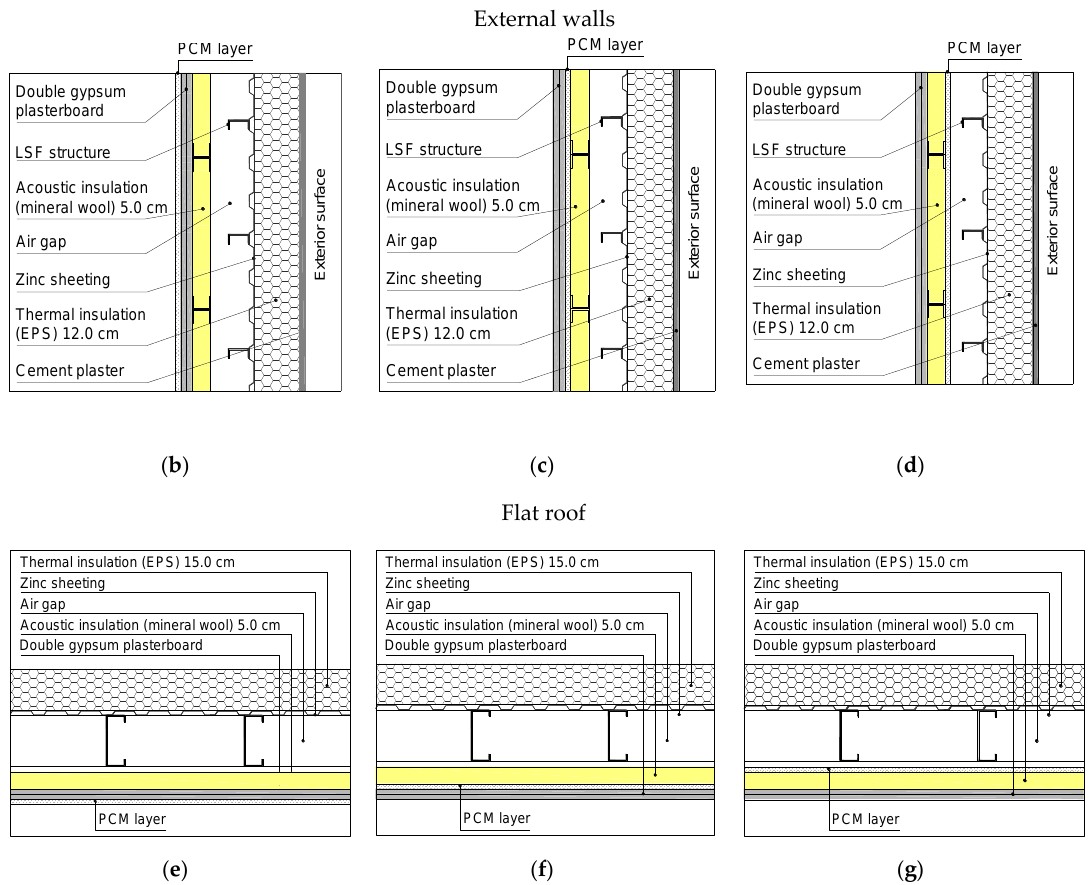
Figure 7. Constructive solutions details including PCM and positioning into the construction solutions: ( a ) cross-sections identification; ( b , e ) position 1: inner surface layer; ( c , f ) position 2: behind the double gypsum plasterboard; ( d , g ) position 3: behind the acoustic layer.